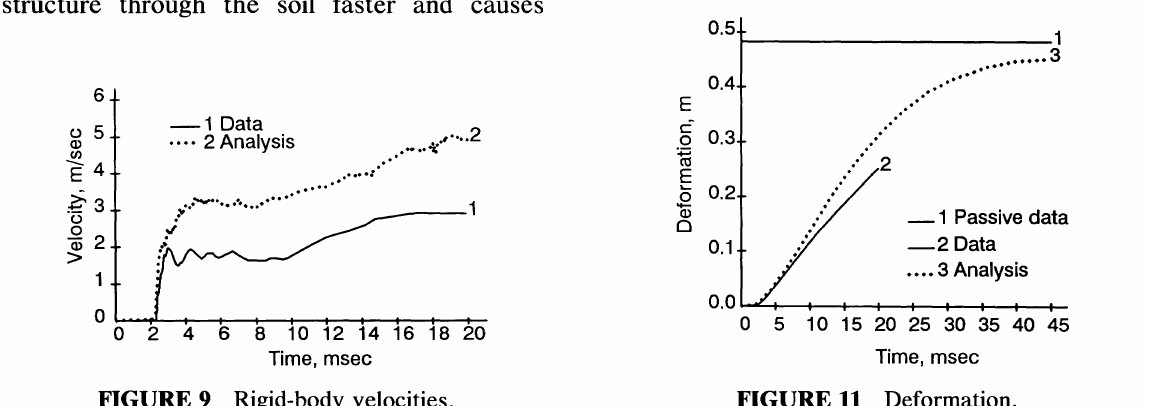
FIGURE 9 Rigid-body velocities.